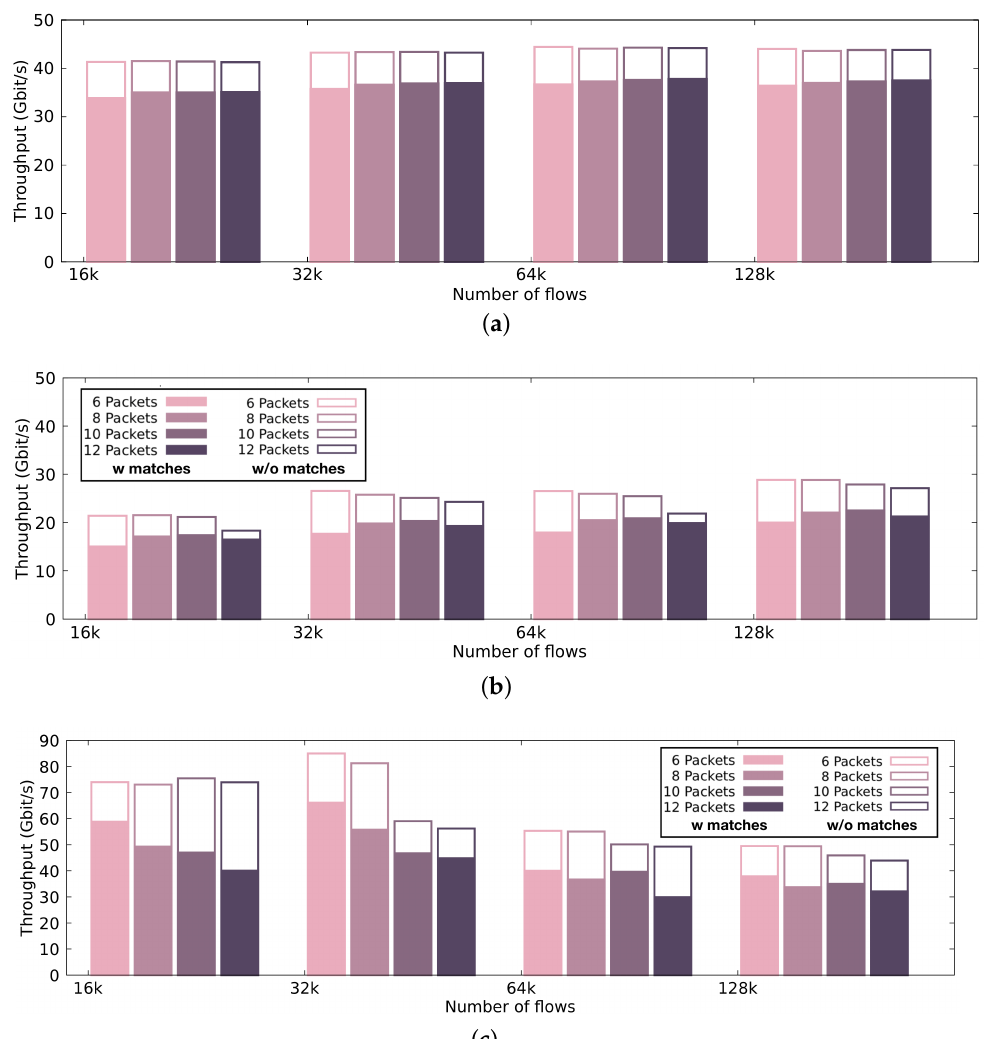
Figure 8. Throughput of our pattern matching engine using a discrete GPU, an integrated GPU and a CPU. Color-filled bars indicate the performance achieved by the pattern matching engine when the selection of (i) signatures and (ii) input results in a computationally loaded condition (i.e., 100% malicious traffic), while the white-filled bars with borders indicate the performance achieved in a computationally relaxed condition (i.e., less than 10% malicious traffic). ( a ) Throughput of the intrusion detection engine using the discrete GPU.; ( b ) Throughput of the intrusion detection engine using the integrated GPU.; ( c ) Throughput of the intrusion detection engine using the